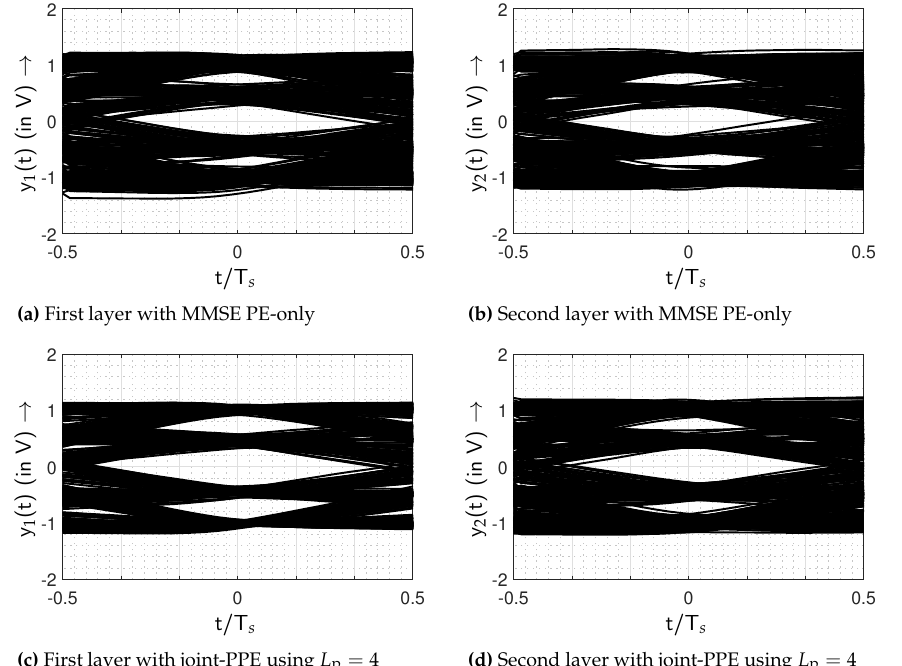
Figure 9. Eye diagrams of the joint-PPE with L p = 4 compared with MMSE PE-only using PAM-4 transmission.